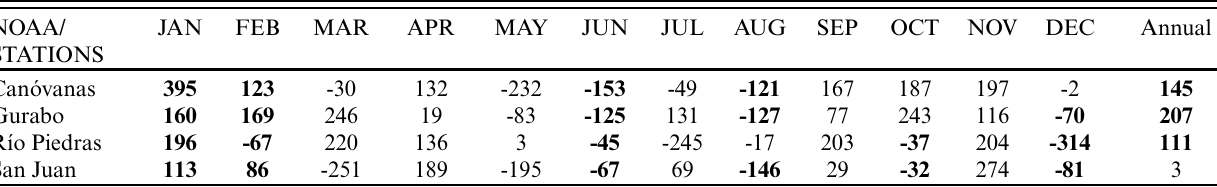
Table 3 . Annual and monthly rainfall trend analysis. Mann-Kendall (S).